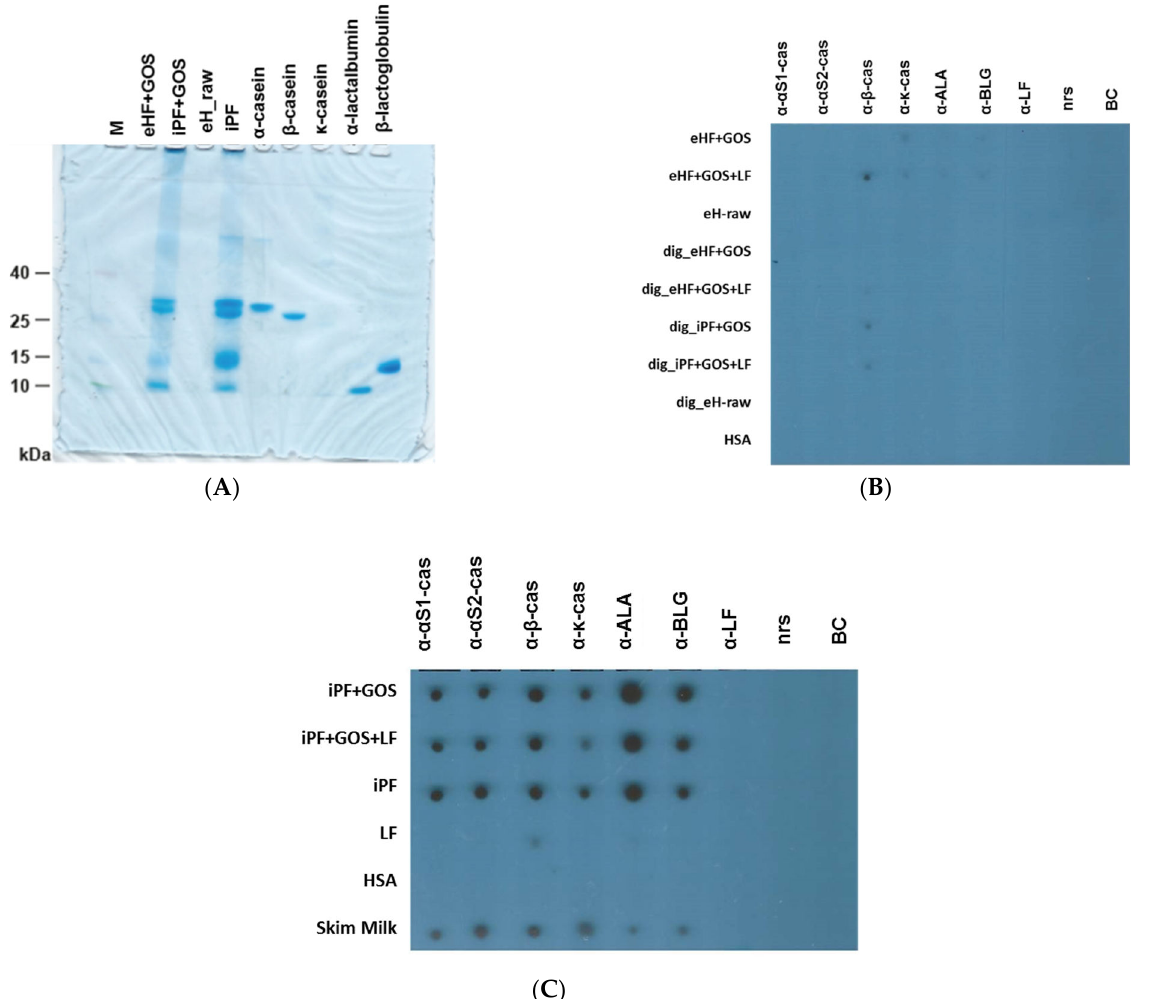
Figure 1. Analysis of materials by SDS-PAGE and dot blotting. ( A ) Infant formulas and milk allergens as indicated on the top (details described in Table 2) were separated by SDS-PAGE and stained with Coomassie Brilliant Blue. A molecular weight marker (lane M) was included, and molecular weights are indicated on the left margin. ( B , C ) Infant formulas, materials and proteins as indicated on the left margin were dotted onto nitrocellulose and then probed with rabbit antisera raised against milk allergens (α-S1-cas, α-S2-cas, α-β-casein, α-κ-casein, α-lactalbumin, α-β-lactoglobulin, and α-lactoferrin), a normal rabbit serum (nrs), or only buffer ( B , C ). Bound rabbit antibodies were detected with 125 I-labeled antibodies and visualized by autoradiography.